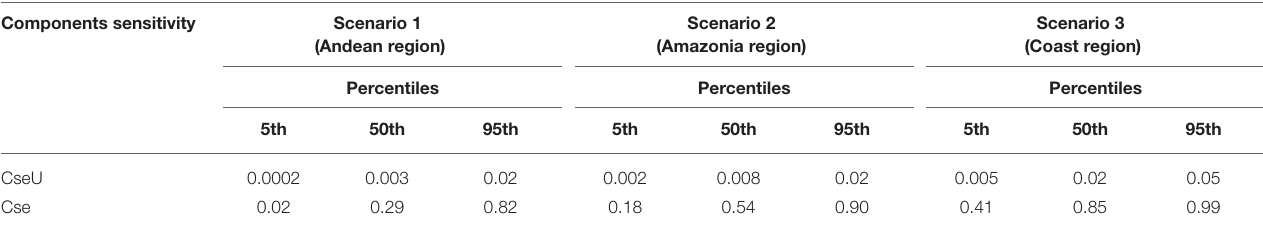
TABLE 6 | Percentiles for surveillance system unit sensitivity and surveillance system component sensitivity, for different geographical scenarios, of the current surveillance system for human leptospirosis in Ecuador. Components